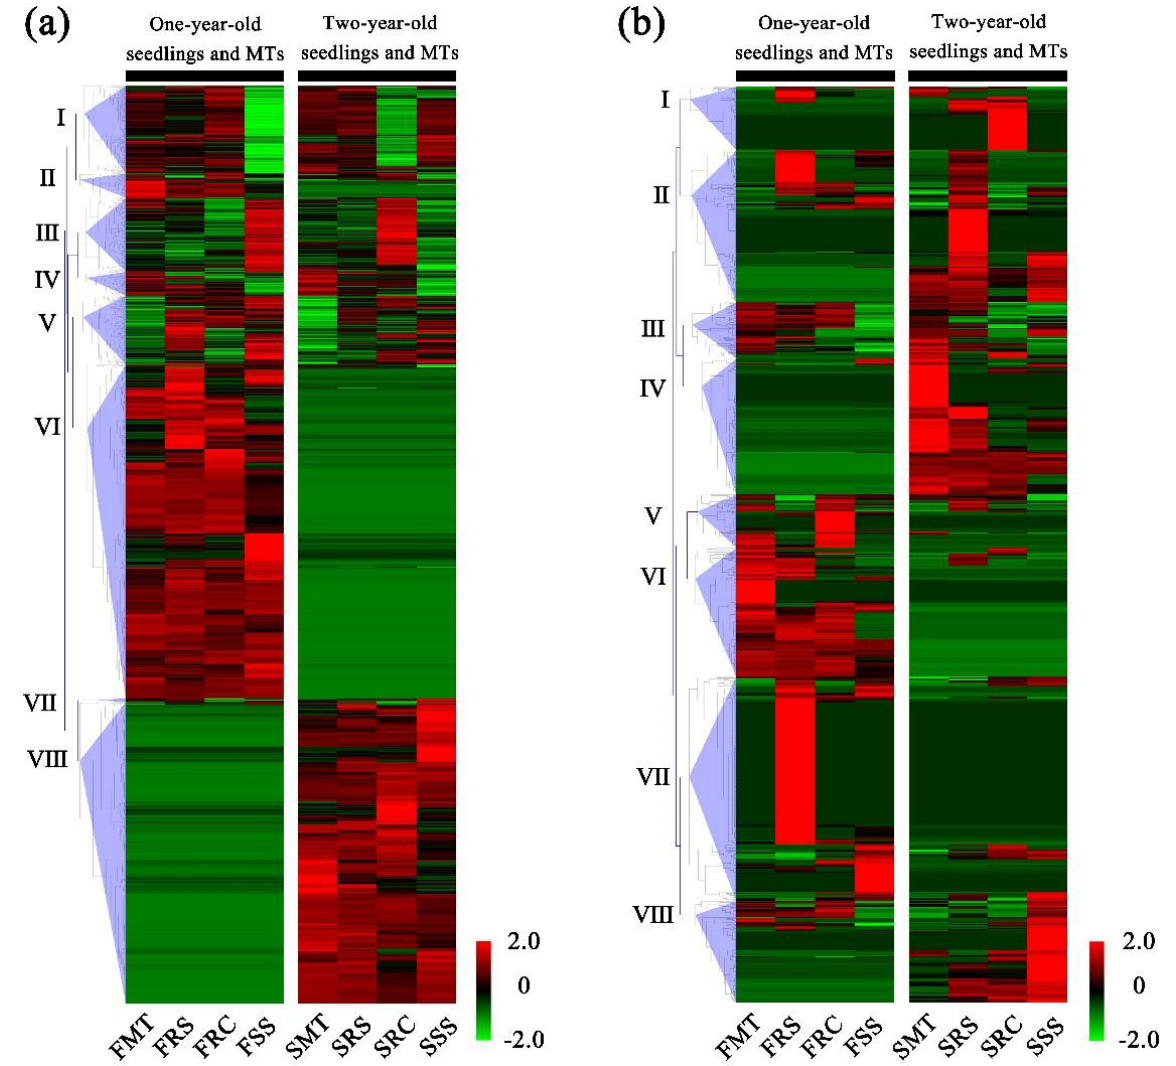
Figure 2. Heatmaps of differentially expressed genes and differentially expressed miRNAs. a 183 Heatmap of differentially expressed genes between mature trees and one- and two-year-old seed- 184 lings; b Heatmap of differentially expressed miRNAs between mature trees and one- and two-year- 185 old seedlings. FMT, mature trees in the first year of sampling; FRS, one-year-old root sprouting 186 seedlings; FRC, one-year-old root cutting seedlings; FSS, one-year-old seed-derived seedlings; SMT, 187 mature trees in the second year of sampling; SRS, two-year-old root sprouting seedlings; SRC, two- 188 year-old root cutting seedlings; and SSS, two-year-old seed-derived seedlings. Each group con- 189 tained three biological replicates (three different trees).